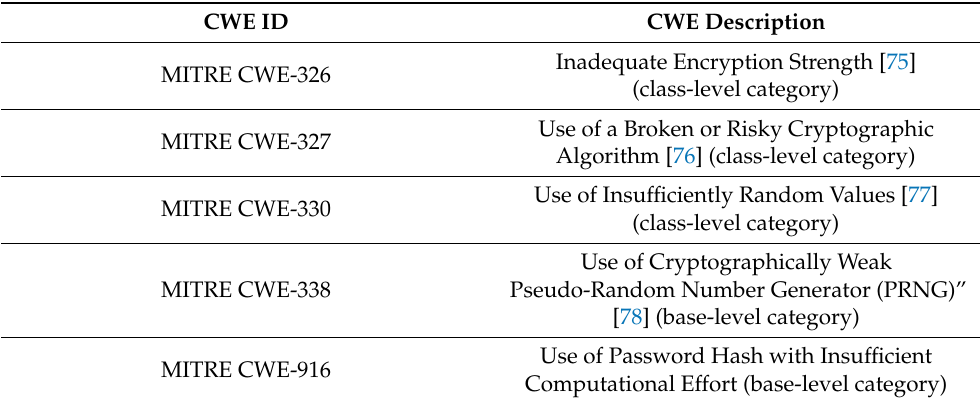
Table 4. MITRE CWEs related to weak cryptography.